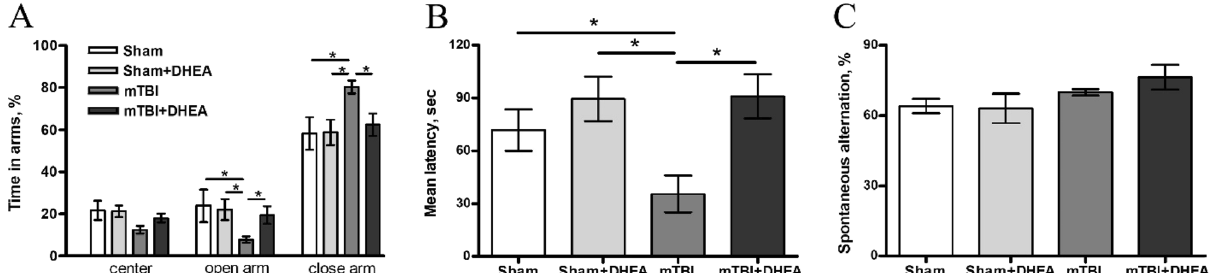
Figure 1. Behavioral effects of mTBI and DHEA treatment. ( A ) Testing anxiety-like behavior with the Elevated plus-maze (EPM). ( B ) The effects of mTBI and DHEA treatment on long-term memory. Passive avoidance test. ( C ) Spontaneous alternation rate differences in Y-maze testing. Data are presented as mean ± SEM, * P < 0.05, n = 14/group (one-way ANOVA, post-test Tukey). Images were prepared with using GIMP 2.10.22 software